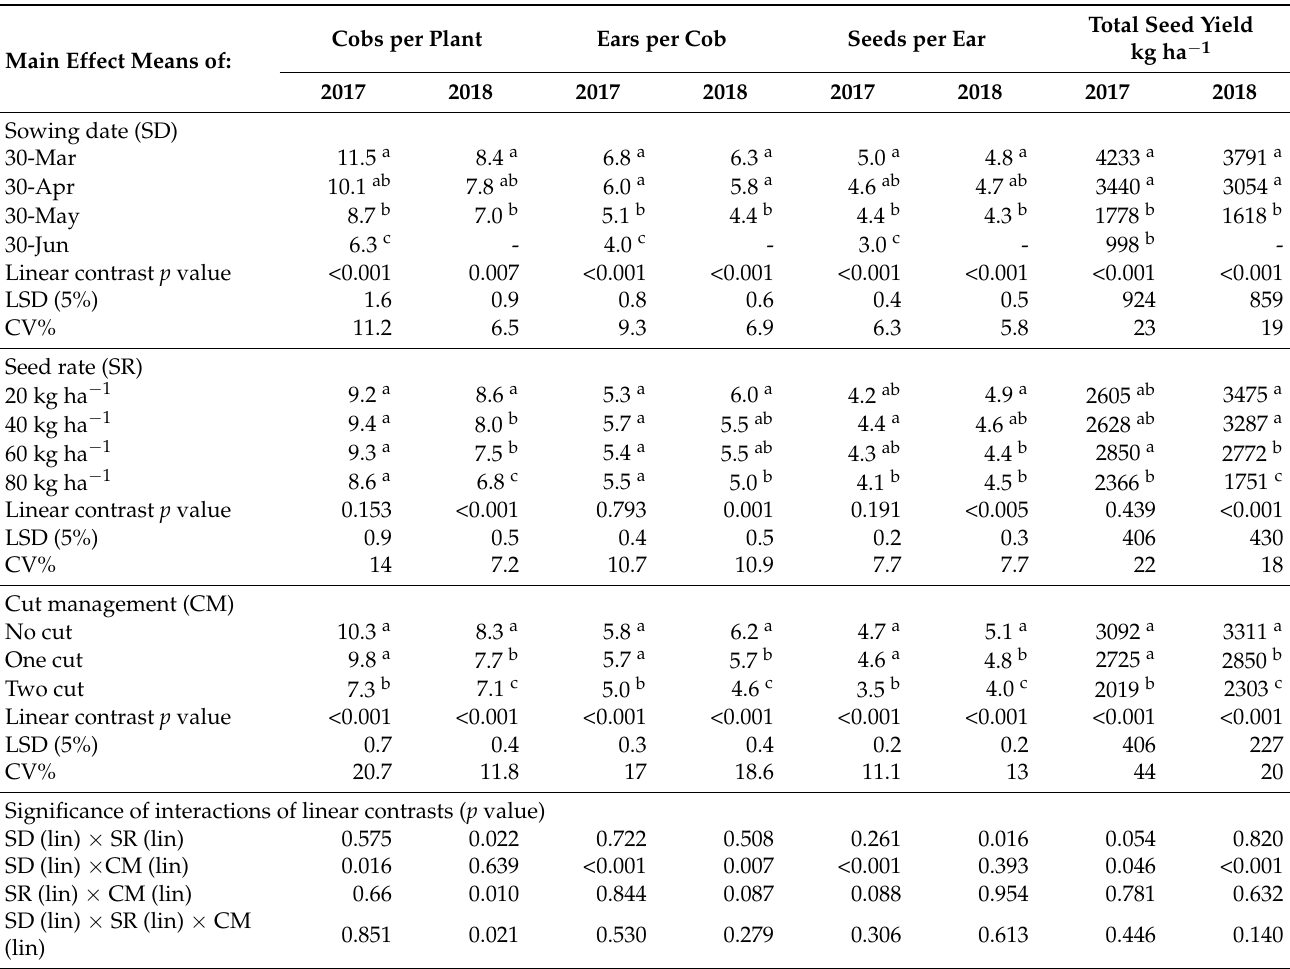
Table 2. Main effect means of sowing date, seed rate and cutting management for teosinte seed yield and yield components in 2017 and 2018 at NCRP, Chitwan,